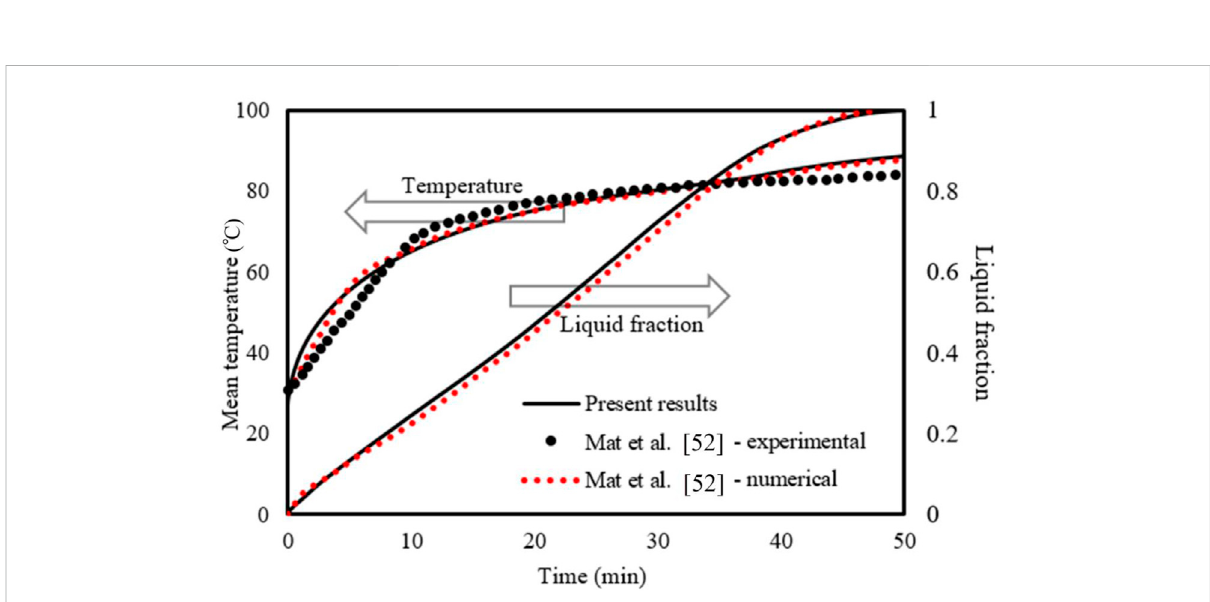
FIGURE 5 Evaluation of the current model ’ s temperature and liquid-fraction results compared to those of Mat et al. (2013).